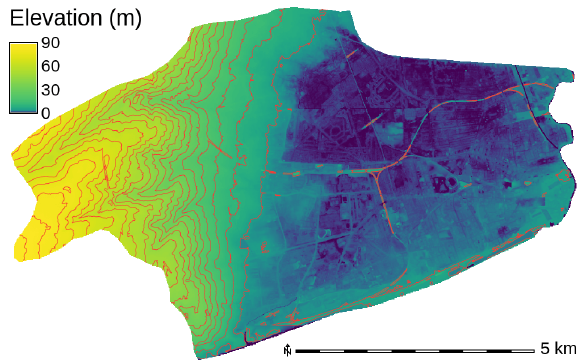
Figure 2. Digital elevation model of the study area. Contour lines are every 5m.